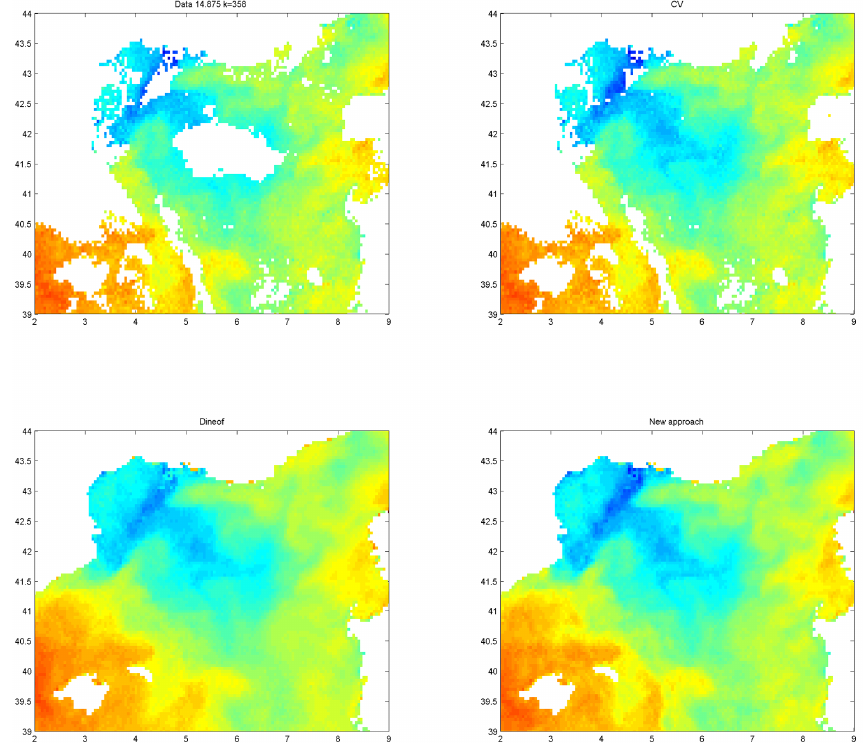
Figure 6. Data used (upper left panel), data including cross-validation data (upper right), DINEOF reconstruction (lower left) and new approach DINEOFOI with 10 iterations (lower